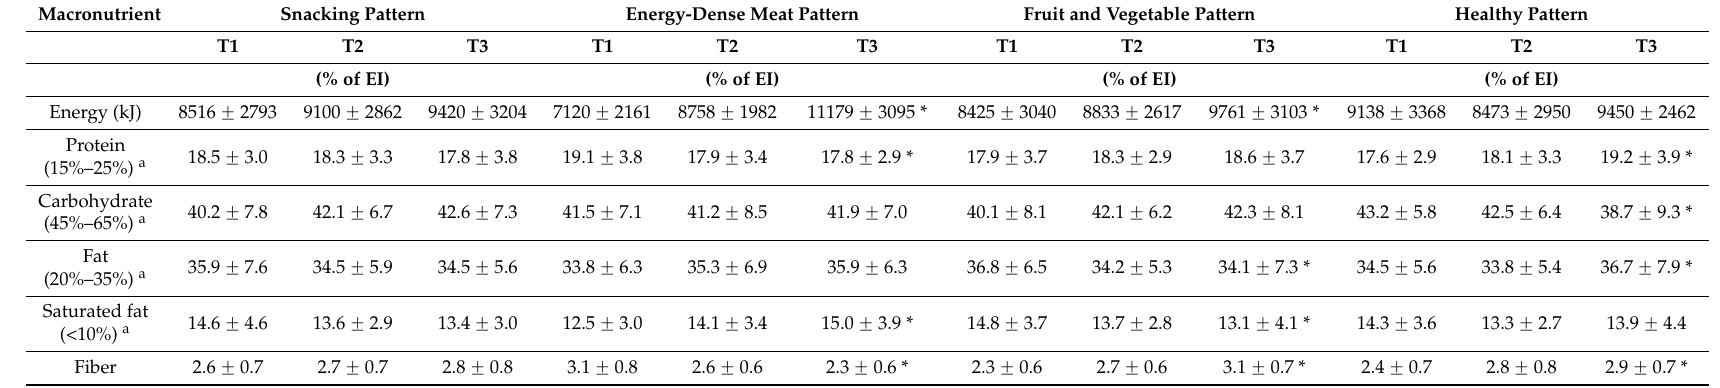
Table 4. Macronutrient distribution profile of dietary patterns in NZE women aged 16–45 years ( n = 231).